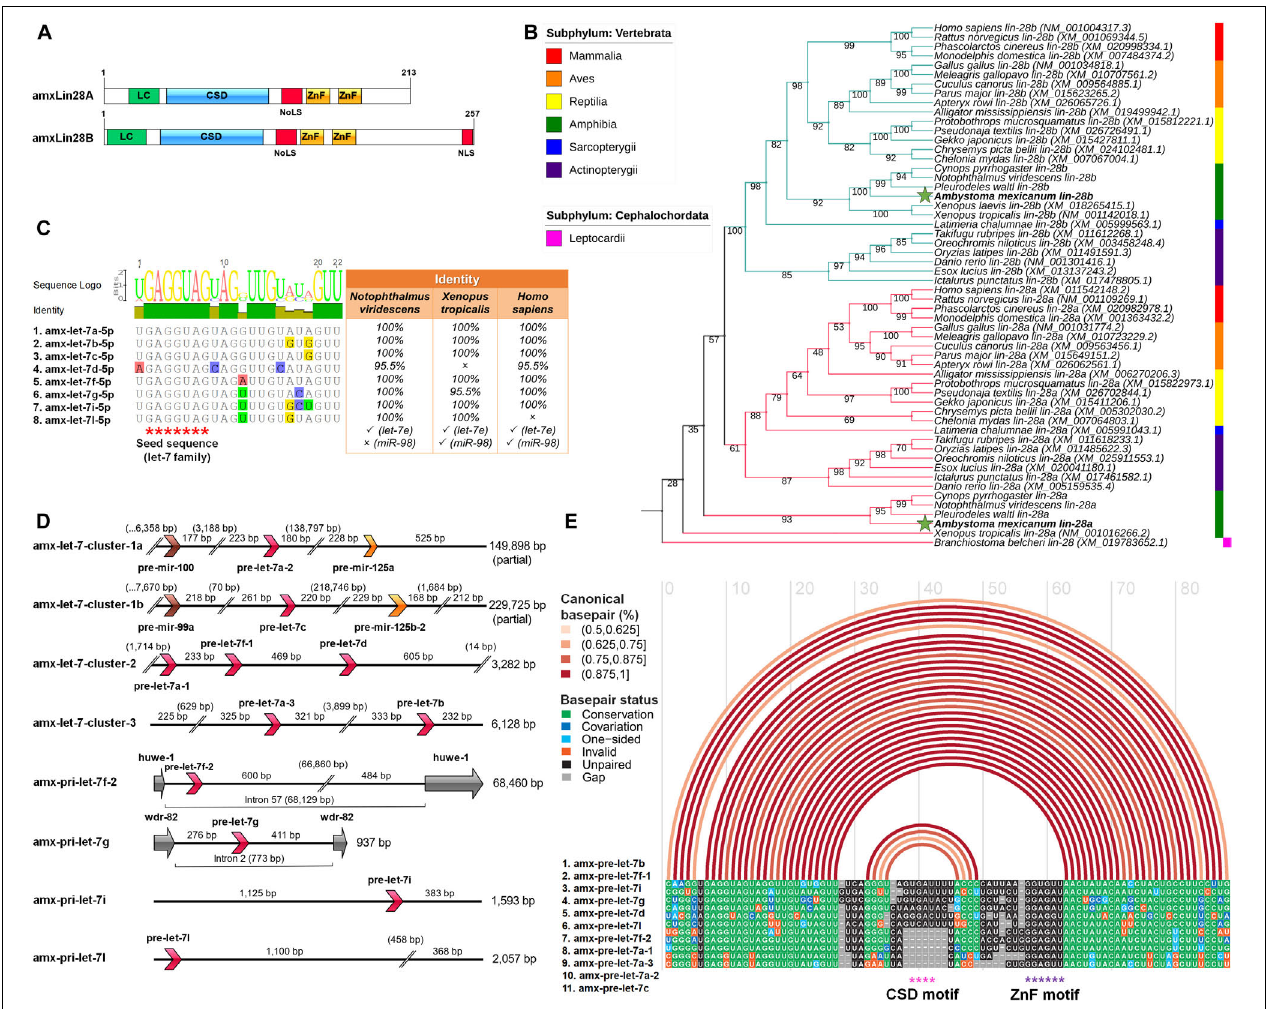
FIGURE 1 | Identification and in silico analysis of members for the Lin28 and let-7 families in axolotl. (A) Domains organization scheme for canonical sequences translated of the amxLin28A and amxLin28B paralogs, where LC is N-terminal low-complexity region; CSD: S1-like cold-shock domain; NoLS: predicted nucleolar localization signal; ZnF: zinc-knuckle domain comprised by two retroviral-type CCHC zinc-fingers motifs; NLS: C-terminal nuclear localization signal present in amxLin28B only. (B) Rooted Maximum Likelihood phylogenetic tree for lin-28 coding sequences of representative vertebrate animals. Bootstrap support was determined by 10,000 replicates. Branch lengths were omitted for the best visualization of the tree. Branch colors indicate different paralogs of lin-28 and green stars highlight the lin-28 sequences of axolotl. (C) Mature let-7 microRNAs confirmed in axolotl and their percentage of sequence identity with respect to equivalent members in other tetrapods. Red asterisks mark the seed sequence region corresponding to the let-7 family. (D) Genomic organization of primary let-7 transcripts in axolotl. Orientation of the different microRNA precursors and exons are shown with directional arrows in different colors to discriminate between distinct microRNA families (pre-let-7: red arrows; pre-mir-125: orange arrows; pre-mir-100/99: brown arrows), or coding exons (gray arrows). (E) Alignment of precursor sequences of the let-7 family in axolotl. Arcs in different shades of red indicate percentages of canonical pairing between base pairs into a secondary folding structure. Asterisks in different colors mark distinct cis-motifs exposed in hairpin-type